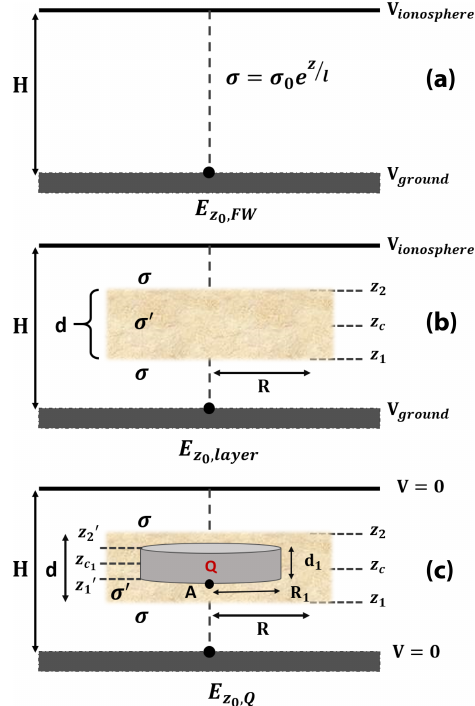
Figure 3. Schematic of the formalism for the calculation of the steady-state near-ground electric field bounded between the ground potential ( V ground ) and ionospheric potential ( V ionosphere ) at height H under (a) fair-weather conditions ( E z ) where atmospheric 0 , FW conductivity σ follows an exponential distribution along the alti- tude z with respect to the scaling height l ; (b) the presence of an electrically neutral dust layer ( E z ) with depth d and radius R , 0 , layer which modifies conductivity to σ (cid:48) ; and (c) the hypothesis of a cylin- ) within the dust layer, with depth drical charged monopole ( E z 0 ,Q d 1 , radius R 1 and total charge Q . The monopole case is a superpo- sition of the electrically neutral dust layer with the charged cylinder within the bounded atmospheric